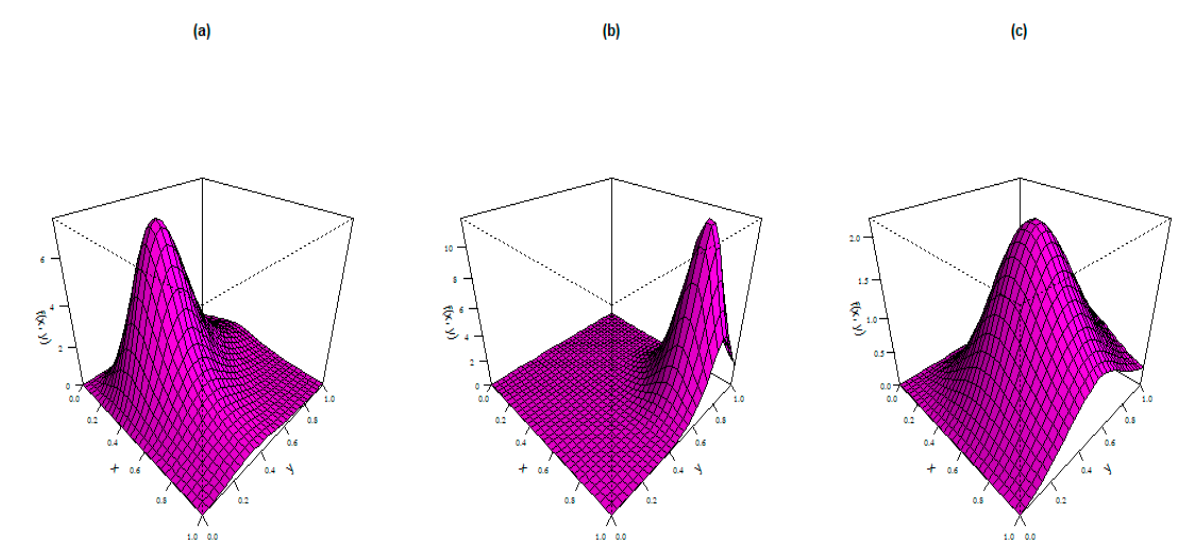
These plots display left-skewed, right-skewed, and approximate symmetrical shapes. Figure 6. PDF plots of the BAP distribution. Figure 6. PDF plots of the BAP